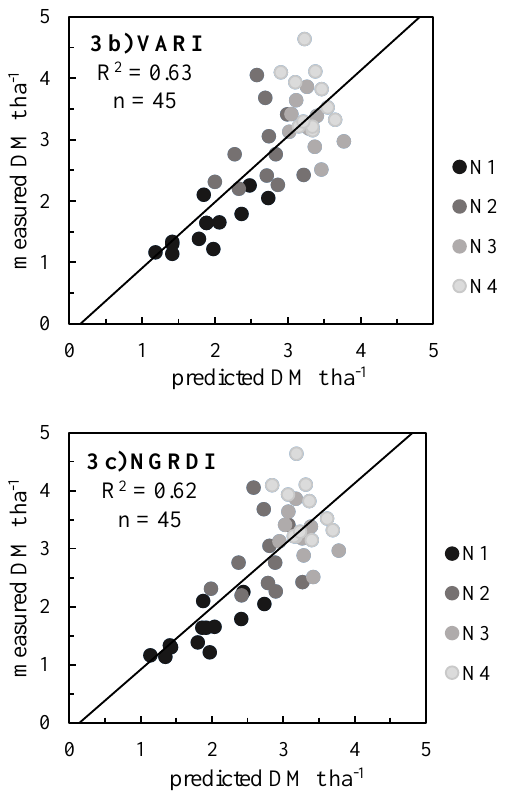
Figure 3 a-c. Cross-validation results for predicted and measured DM t ha -1 from validation subset of VIs derived from the orthomosaic. N1: 0 kg N ha -1 , N2: 50 kg N ha -1 , N3: 100 kg N ha -1 , N4: 150 kg N ha -1 . The GLI performs least of the remaining VI RGB (R 2 = 0.36). The